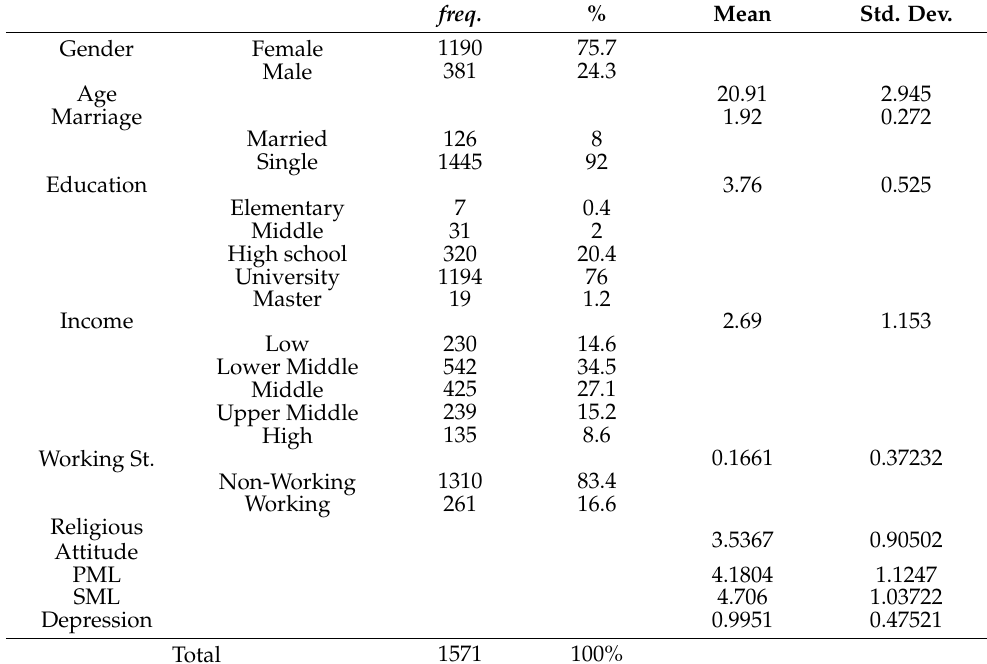
Table 1. Descriptive